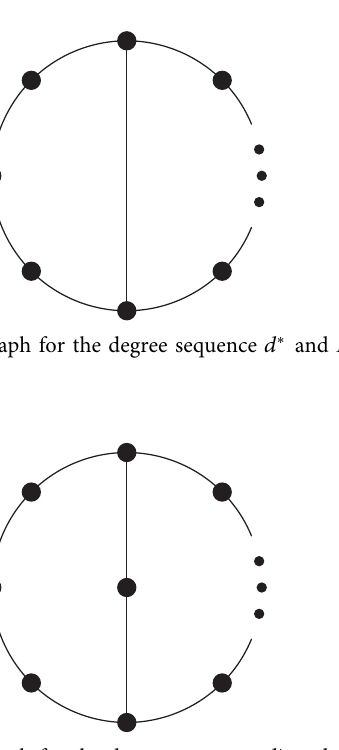
8 α +(54) α 2 (31) α Figure 11: Plot for A − B , and it shows that A > B .